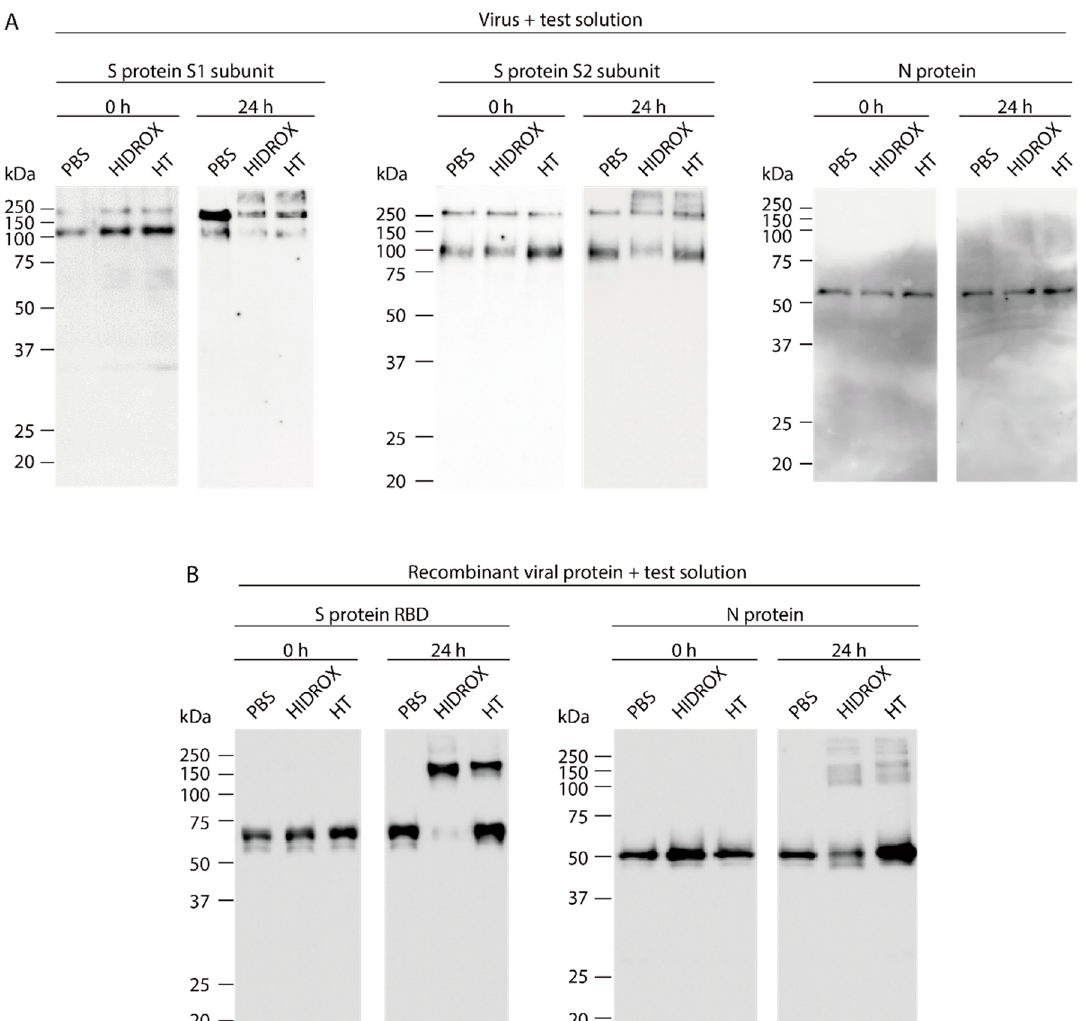
Figure 3. Impact of hydroxytyrosol (HT)-rich aqueous olive pulp extract (HIDROX) and HT on severe acute respiratory syndrome coronavirus 2 (SARS-CoV-2) proteins. ( A ) SARS-CoV-2 was mixed with HIDROX or HT. The final concentrations of HIDROX and HT in the mixture were 0.90 mg/mL. As a diluent control, PBS was mixed with the viral suspension. The mixtures were incubated at 25 °C for 0 (no reaction time) or 24 h, and then Western blotting was performed. The images on the left, middle, and right show the results of Western blotting to detect S protein S1 subunit, S protein S2 subunit, and N protein, respectively. ( B ) The recombinant S protein RBD or N protein was mixed with PBS, HIDROX, or HT. The final concentration of HIDROX and HT in the mixture was 0.90 mg/mL. The final concentration of recombinant viral proteins in the mixture was approximately 10 µg/mL. The mixtures were incubated at 25 °C for 0 (no reaction time) or 24 h and then Western blotting was performed. The images on the left and right show the results of Western blotting to detect S protein RBD and N protein, respectively.